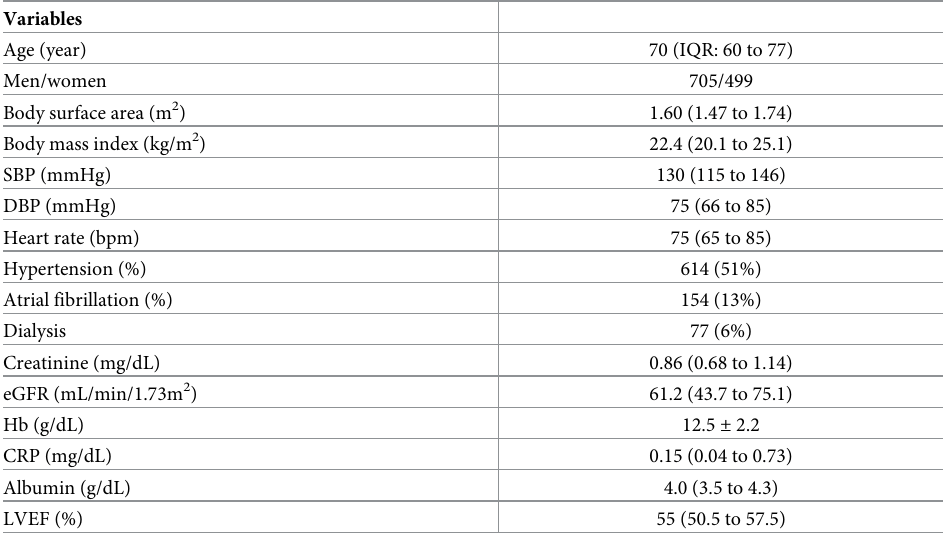
Table 1. Patient characteristics (n = 1204).